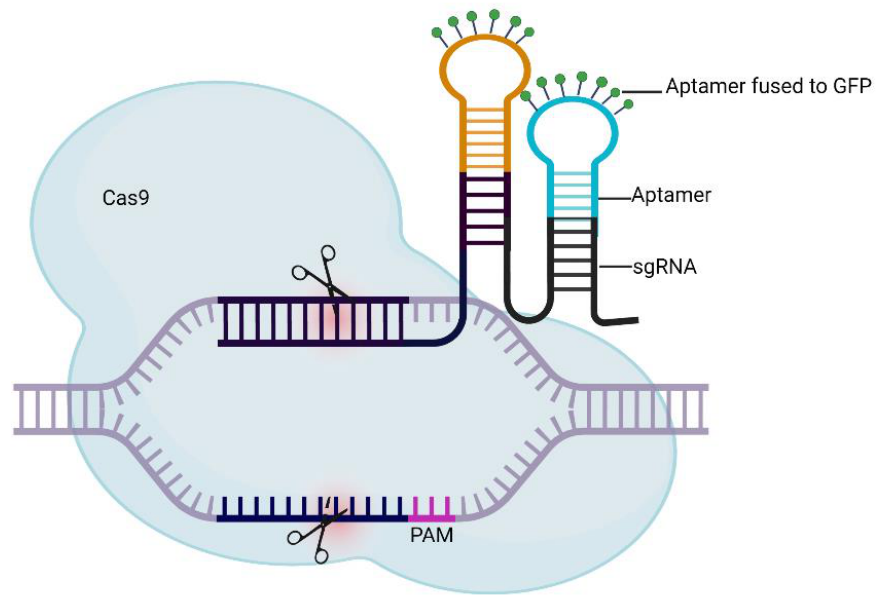
Figure 3. Schematic illustration of aptamer integration in CRISPR/Cas system. The aptamer construct is integrated into the sgRNA scaffold and can be detected with a green fluorescent protein, which is fused to aptamer stem–loop structure. Figure is adapted from Khosravi et al. [52]. The figure was created with BioRender.com.